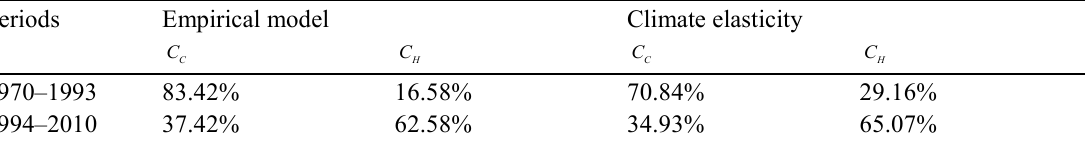
Table 1 Contributions of climate change and human activities to the runoff change in BRB determined by the empirical model and climate elasticity. Periods